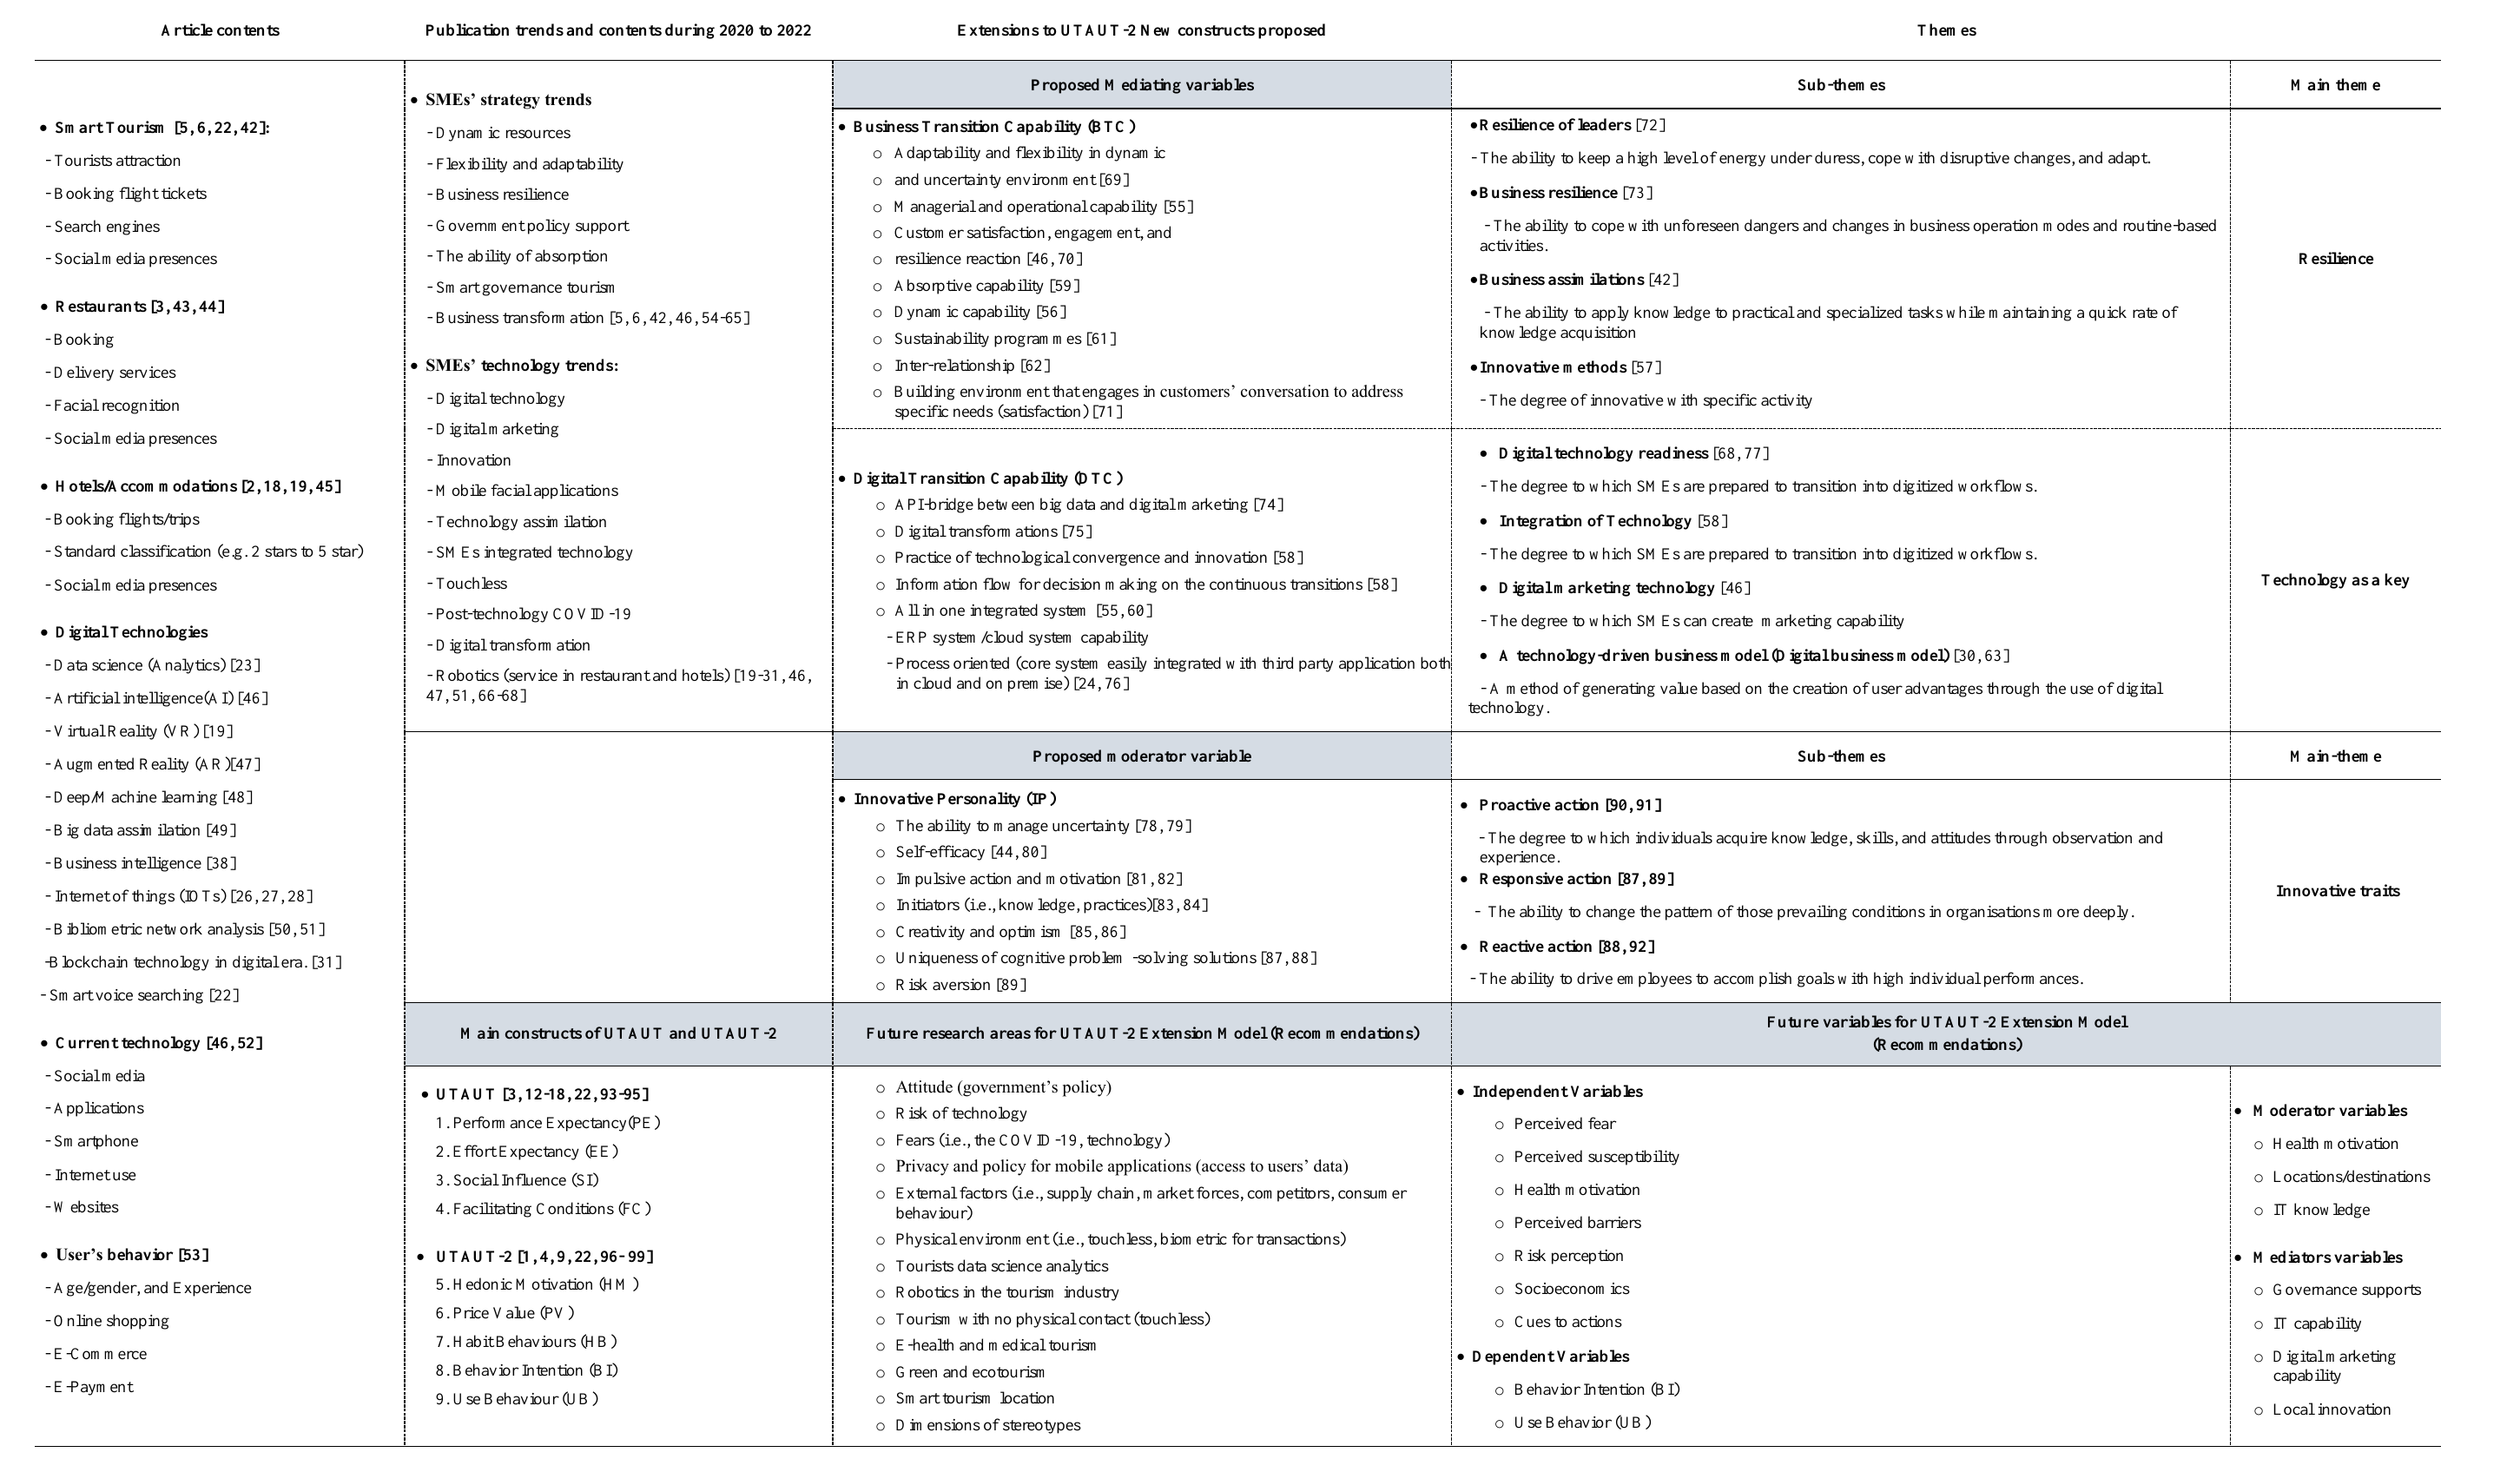
Table 2. Classification framework of categories, sub-themes and main themes of research constructs during the COVID-19 pandemic (2020 to